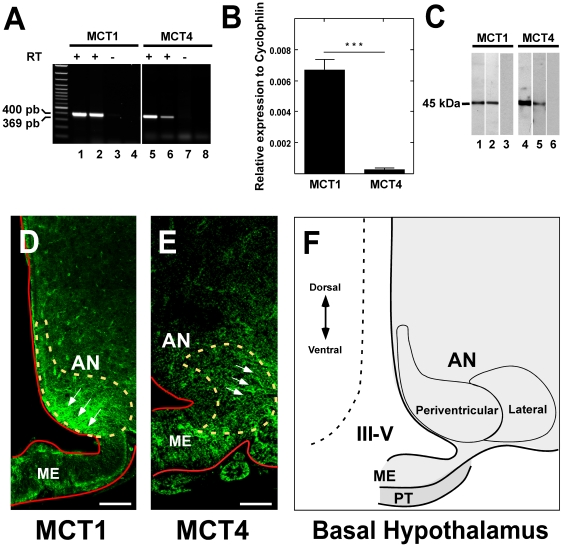
MCT1 and MCT4 expression and localization in adult rat hypothalamus.
A, RT-PCR analysis of MCT1 and MCT4. MCT1 RT-PCR products obtained using total RNA isolated from: Lane 1, kidney cortex; 2, hypothalamus; 3 RT(-) of hypothalamus; 4, water in the PCR reaction. MCT4 RT-PCR products obtained using total RNA isolated from: Lane 5, skeletal muscle; 6, hypothalamus; 7 RT(-) of hypothalamus; 8, water in the PCR reaction. B, Quantitative RT-PCR analysis of the MCT1 and MCT4 mRNA levels in samples isolated from rat hypothalamus. **p<0.001. Data represent the means ± SD of the ratio of MCT mRNA to cyclophilin mRNA from three independent experiments. C, Western blot analysis of MCT1 and MCT4. Lanes 1–3, MCT1; 4–6, MCT4. Total protein extracts were prepared from renal cortex (lane 1), hypothalamus (lanes 2 and 5), negative control (lanes 3 and 6), and skeletal muscle (lane 4). Negative controls were performed in hypothalamus with primary antibodies preabsorbed with inductor peptides (lanes 4 and 6). D, Immunohistochemistry of MCT1 and confocal microscopy analysis. MCT1 is observed in the arcuate nucleus periventricular region (arrows). E, Immunohistochemistry of MCT4 and confocal microscopy analysis. MCT4 is localized in the arcuate nucleus lateral area (arrows). F, Schematic representation of basal hypothalamus. AN, arcuate nucleus; III-V, third ventricle; ME, median eminence; PT, pars tuberalis. Scale bar D–E, 200 µm.